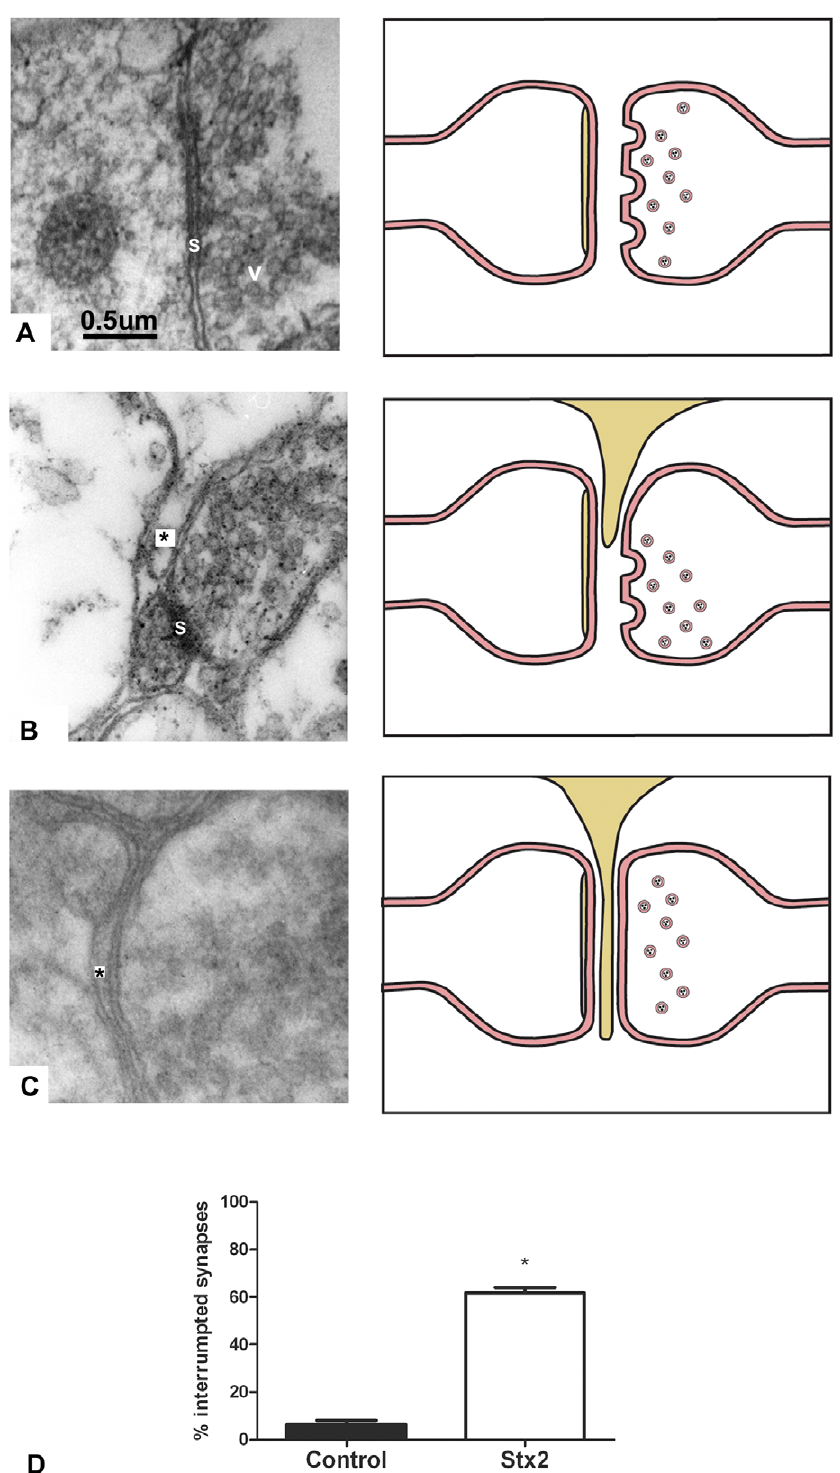
Figure 5. Intravenous administration of Stx2 causes synaptic modifications. Electron micrograph showing an apparently normal synapse (s) and pre-synaptic vesicles (v) in the striatum (A). Electron micrograph showing an increased number of pre-synaptic vesicles together with an incipient astrocytic process (*) in close proximity to a synaptic space (S) in the lower left corner (B). Electron micrograph showing full astrocytic interposition in the synaptic space (*) while the pre-synaptic terminal is full of vesicles (C). Chart illustrating the process in the synaptic space (right panel). Percentage of interrupted synapses in the striatum from Stx2-treated mice vs. vehicle-treated ones (D). An asterisk denotes statistical significance, p , 0.05. Results are expressed as a percentage of the total number of synapses in an area of 3721 m m 2 . The scale bar in A applies to all micrographs.